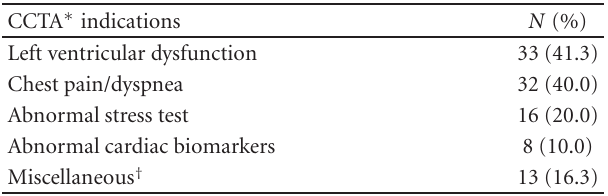
Table 2: Indications for cardiac computed tomographic angiogra- phy.